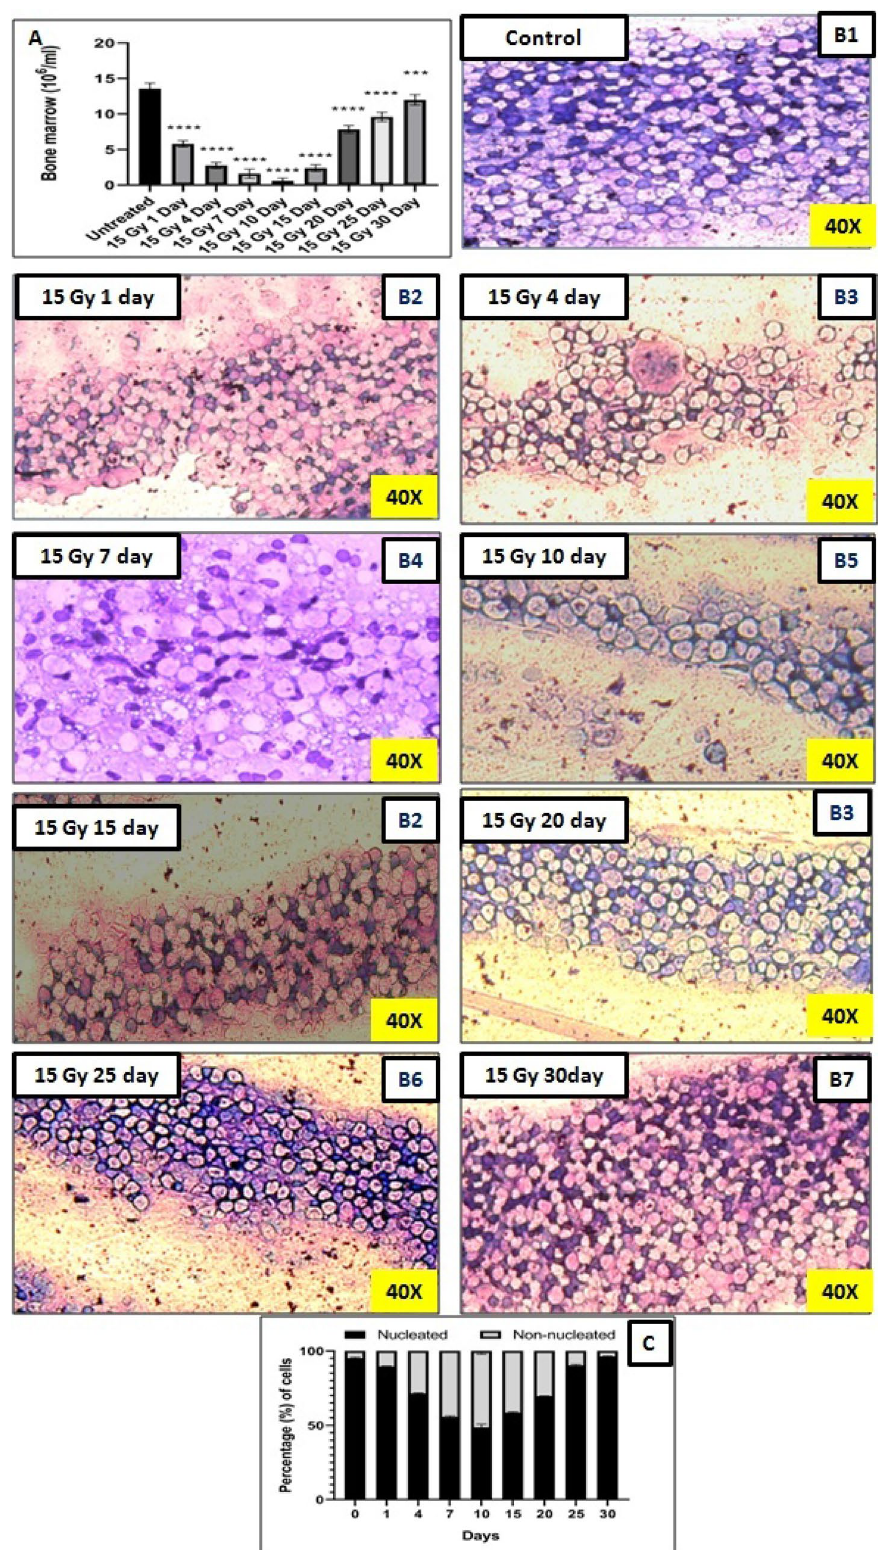
Figure 4. Represents the bone marrow counts and differential bone marrow counts in terms of nucleated and non-nucleated cells at different time points ( A ) Bone marrow counts of untreated and treated mice at various time intervals. ( B 1–7 ) Representative images of bone marrow smear which shows nucleated and non-nucleated cells of untreated and treated samples at various time points. ( C ) The bars represent the nucleated and non-nucleated cells population post-irradiation. The bars represent the mean ± SD of 6 animals. A value of p < 0.05 is considered statistically significant *p < 0.05, **p < 0.01, ***p < 0.001, ****p < 0.0001, ns = not significant (p >